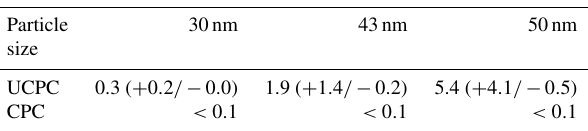
Table 1. Remaining fraction (%) of tetracontane (C 40 H 82 ) particles measured by the UCPC and CPC downstream of the evaporation